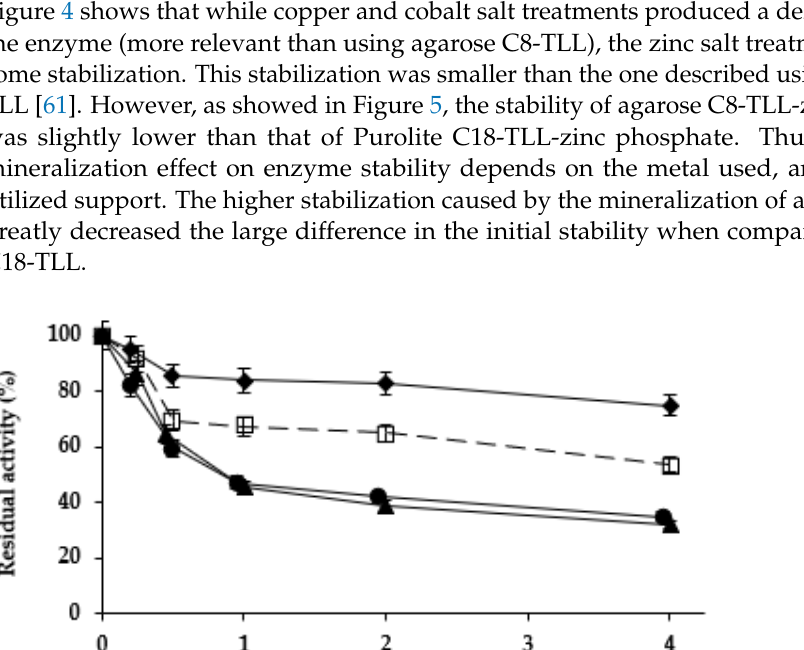
Figure 5. Thermal inactivation courses of agarose C8-TLL-ZnP (rhombus) and Purolite C18-TLL- ZnP (squares). Other specifications are described in Methods. 3. Materials and Methods 3.1. Materials A TLL solution (20.77 mg protein/mL) was kindly donated by Novozymes Spain (Madrid, Spain). Bradford’s reagent (utilized to calculate the protein concentration [87]), p -nitrophenyl-butyrate ( p -NPB), triacetin, R - and S -methyl mandelate, triacetin, acetoni- trile for HPLC (gradient grade, ≥ 99.9%), cobalt chloride (CoCl 2 ), copper chloride (CuCl 2 ), and zinc chloride (ZnCl 2 ) were purchased from Sigma-Aldrich (St. Louis, MO, USA). Purolite Lifetech ® ECR8806F (methacrylate macroporous resin containing octadecyl groups) (Purolite C18) with an average porous diameter of 38.5 nm under dried conditions [88] was kindly donated by Purolite ® Ltd. (Wales, UK). Octyl Sepharose ® CL-4B (agarose C8) was acquired from GE Healthcare (Uppsala, Sweden), presenting an average porous dimeter of 153 nm in wet conditions [74]. All other reagents were of analytical grade. 3.2. Methods The experiments were repeated 3 times, and the values are given as mean values and standard deviation.